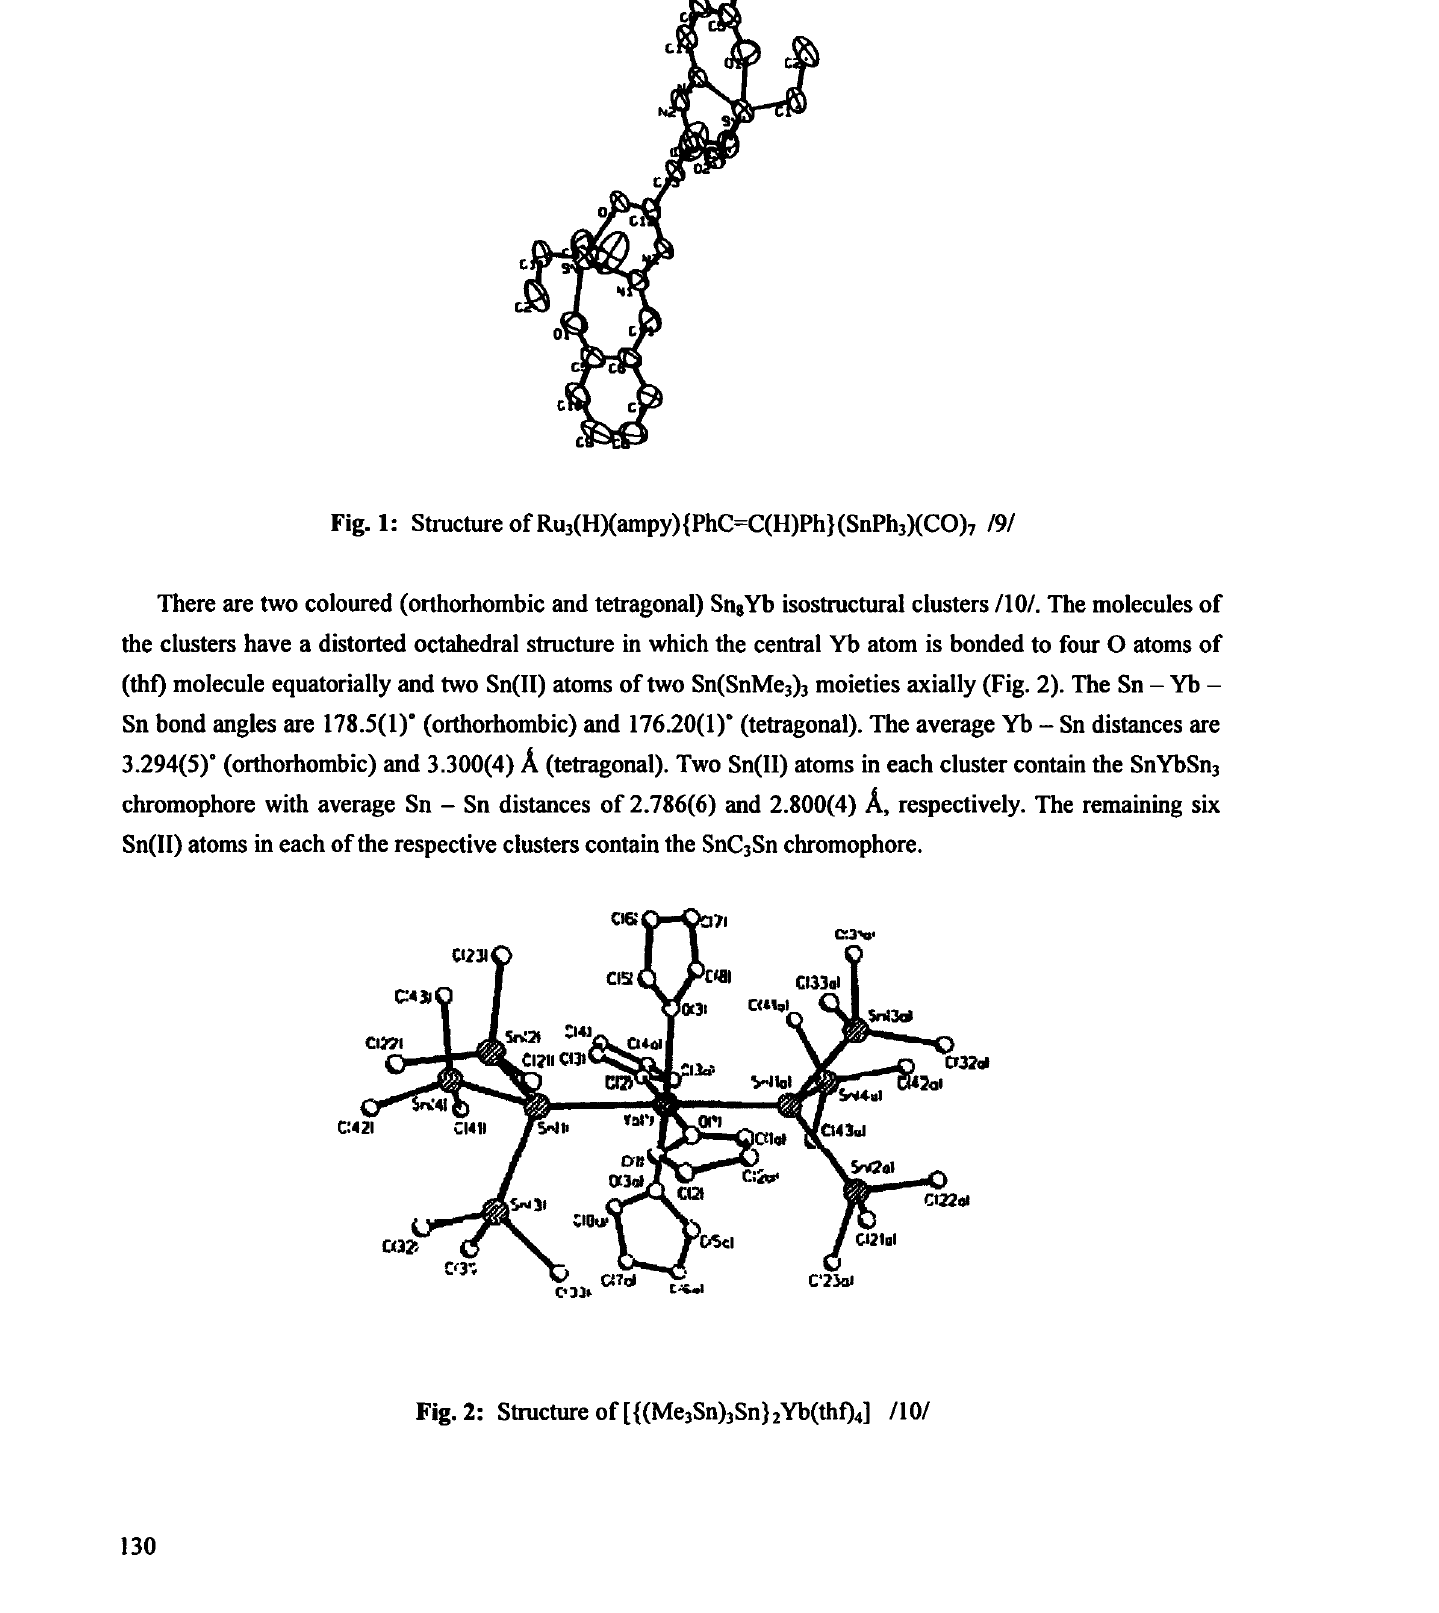
Fig. 2: Structure of [{(Me